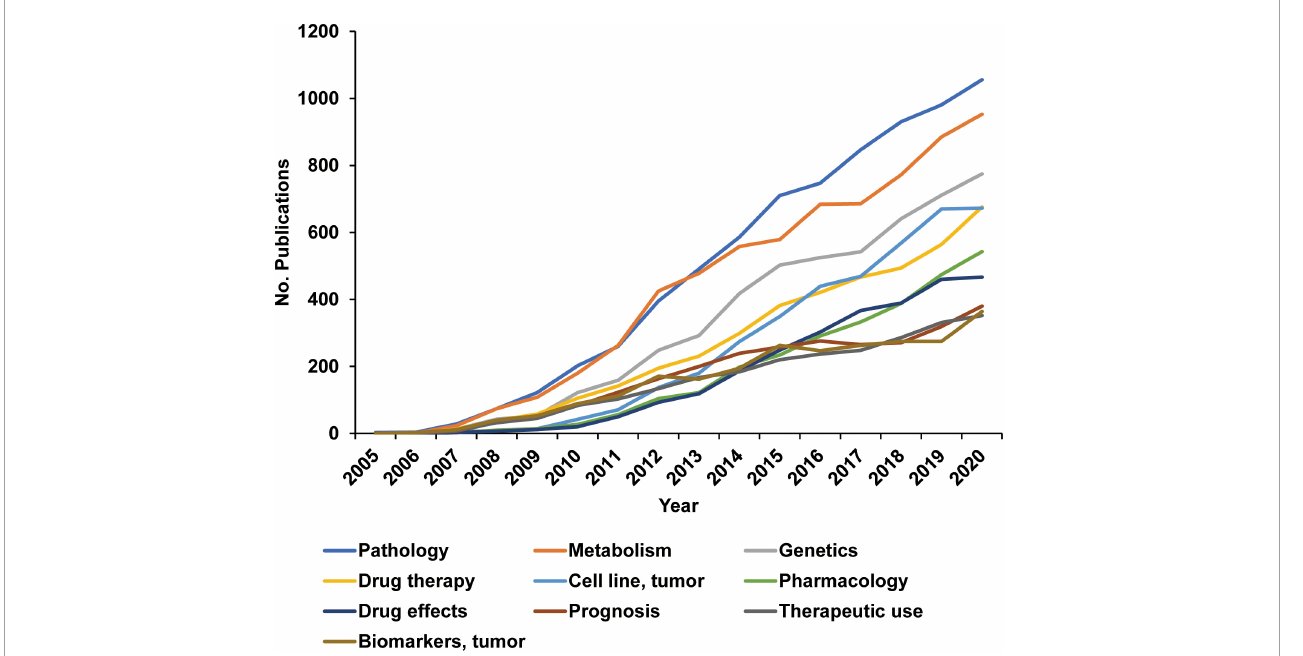
FIGURE4 Molecular pathogenesis and medication are most studied in triple-negative breast cancer (TNBC) research. Each publication contains several Medical Subject Headings terms to describe the research content roughly. R was used to analyze the themes of the publications through Medical Subject Headings terms. The figure shows the most researched topics in the last 16